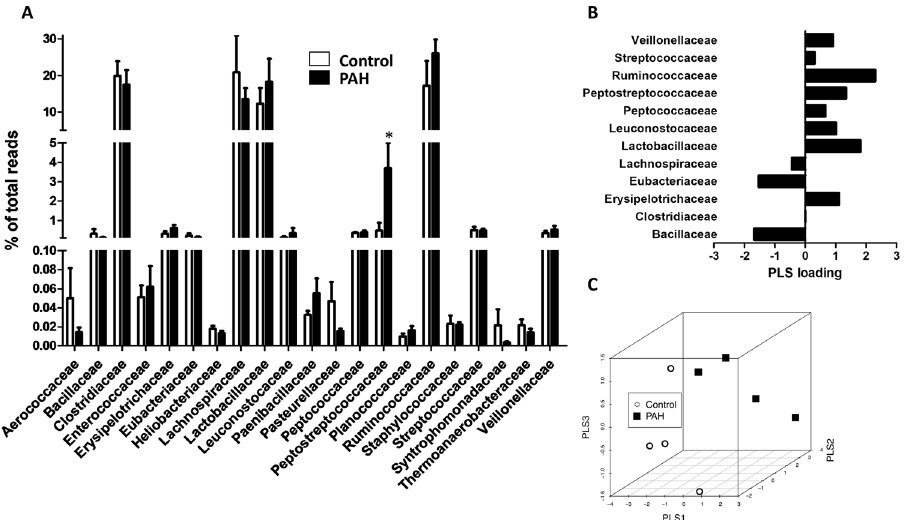
Figure 4. Bacterial families within the Firmicutes phylum. ( A ) Composition of the most abundant bacterial families ( > 0.01%) expressed as a percent of total bacteria in control and PAH rats (means ± s.e.m. of 4 animals, * p < 0.05 vs control with student’s t-test). ( B ) PLS loadings (data shown for phyla representing > 0.1% of total bacteria) highlight variable significance to discriminate between PAH and control samples in PLS scores. ( C ) Tridimensional PLS scores